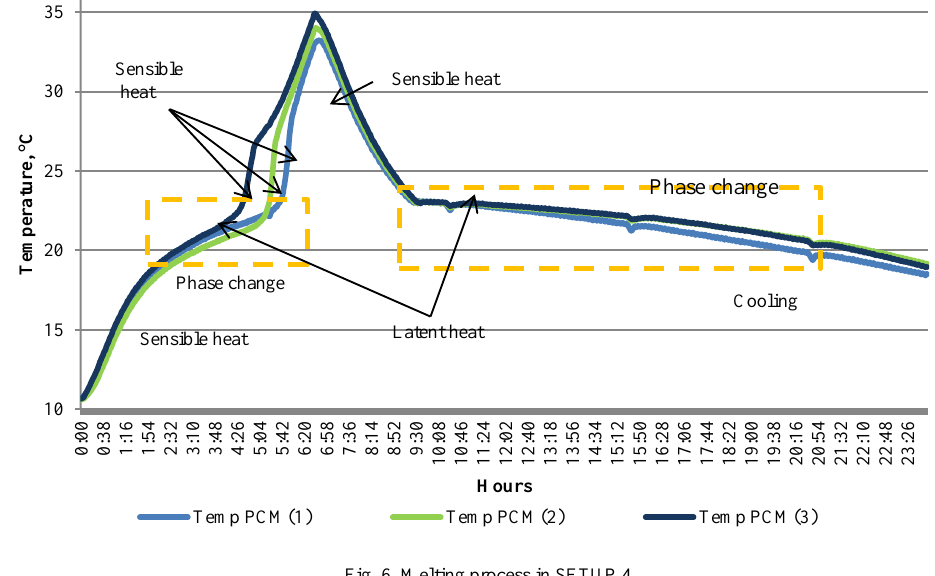
Fig. 6. Melting process in SETUP